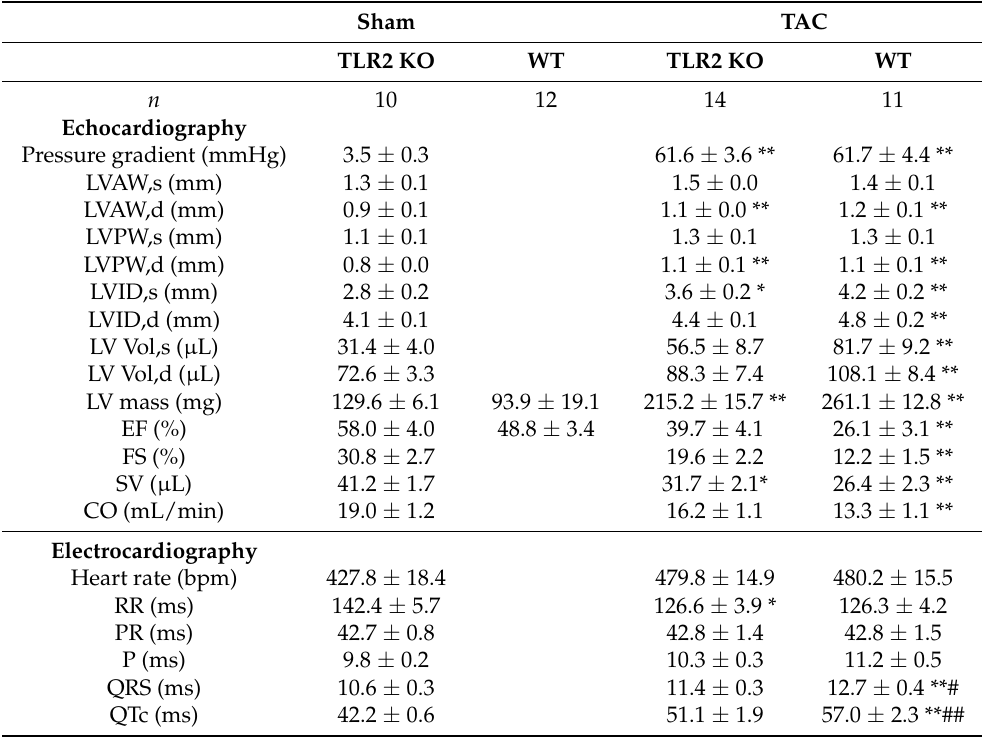
Table 1. Echocardiographic and electrocardiographic measurements of TLR2 KO sham, TLR2 KO TAC, and WT TAC mice 12 weeks after surgery and historical WT sham after 8 weeks. Values are mean ± SEM for TLR2 KO sham, TLR2 KO TAC, and WT TAC mice and mean ± SD for WT sham mice. QTc was calculated using Bazett’s formula. LV, left ventricle; LVAW,s and LVAW,d, end-systolic and end-diastolic LV anterior wall thickness, respectively; LVPW,s and LVPW,d, end-systolic and end-diastolic LV posterior wall thickness, respectively; LVID,s and LVID,d, LV internal diameter end-systole and end-diastole, respectively; LV Vol,s and LV Vol,d, end-systolic and end-diastolic LV volume, respectively; EF, ejection fraction; FS, fractional shortening; SV, stroke volume; CO, cardiac output. * p < 0.05 and ** p < 0.01 compared to TLR2 KO sham; # p < 0.05 and ## p < 0.01 compared to TLR2 KO